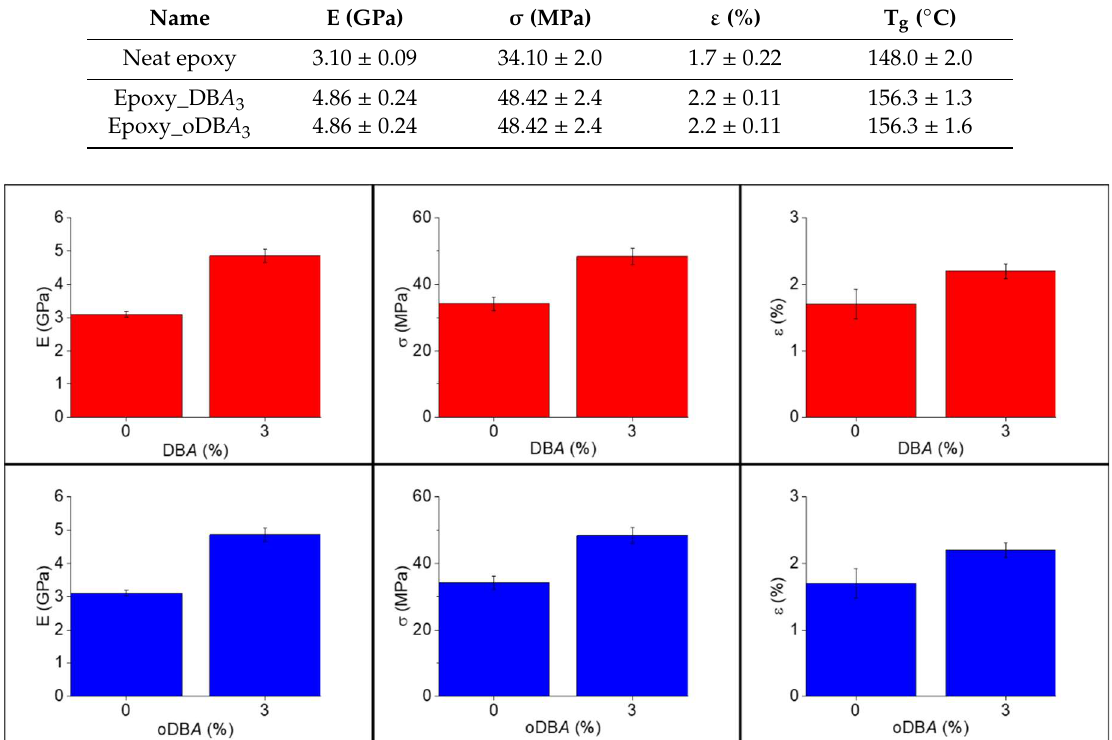
Figure 7. Flexural modulus (E), strength ( σ ), and strain to break ( ε ) of the epoxy composites as a function of the content of DBA and oDBA and compared to neat epoxy samples. Table 7. Mechanical properties and glass transition temperature of the epoxy composites obtained after dynamic DSC scans up to 250 °C.